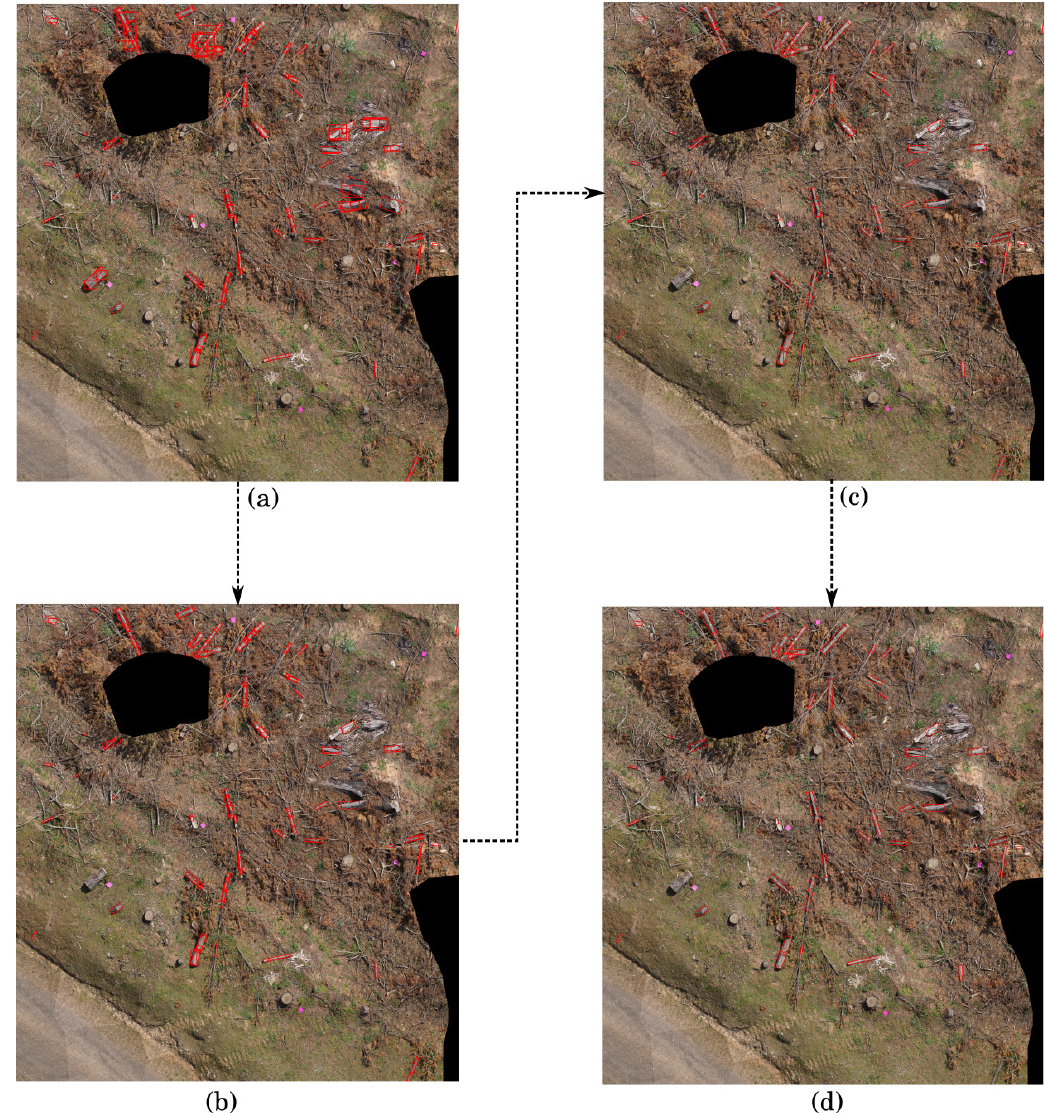
Figure 7. The rectangle refinement process. The bounding boxes found are used in conjunction with the segmented image to fit rectangles to logs (Figure 6), giving ( a ). Rectangles that are too square or that have a short side that is unrealistically large are removed ( b ). The rectangles are then refined by merging those with both similar orientations and close centers ( c ). Of the remaining rectangles, those that overlap significantly with other rectangles or are unrealistically large are removed ( d